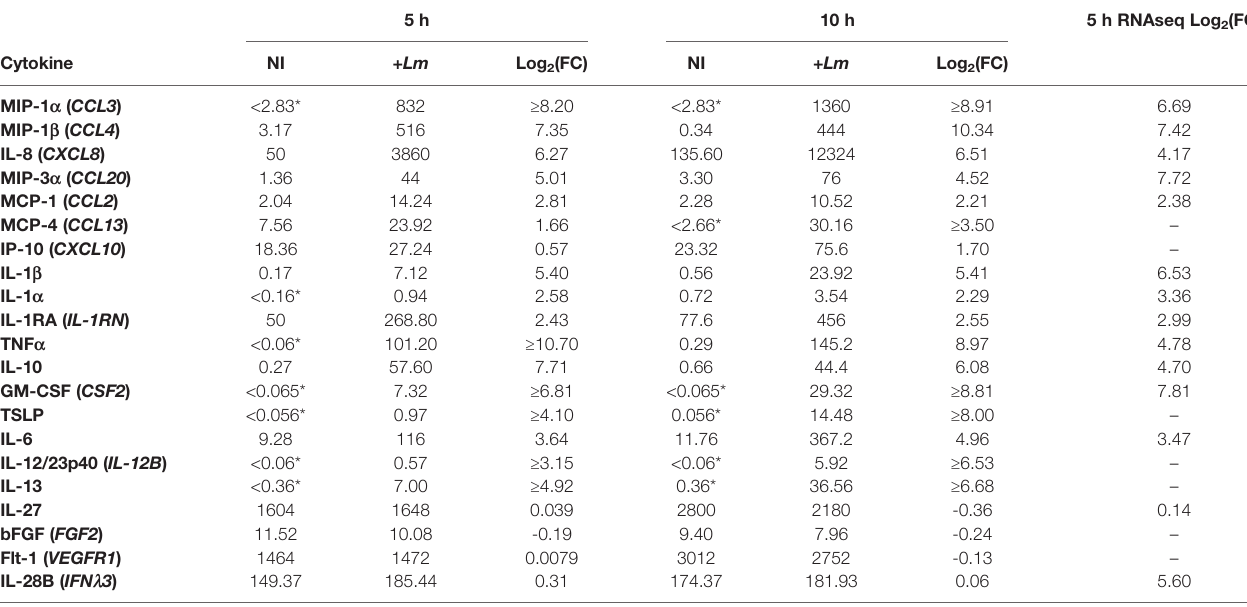
TABLE 4 | PHT cytokine